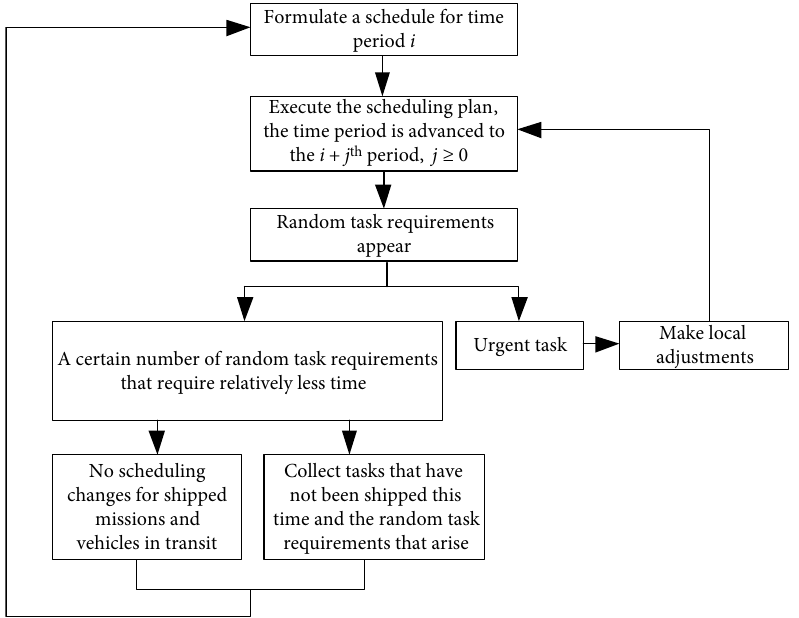
Figure 5: Rolling scheduling strategy for hazardous materials transport fleet.